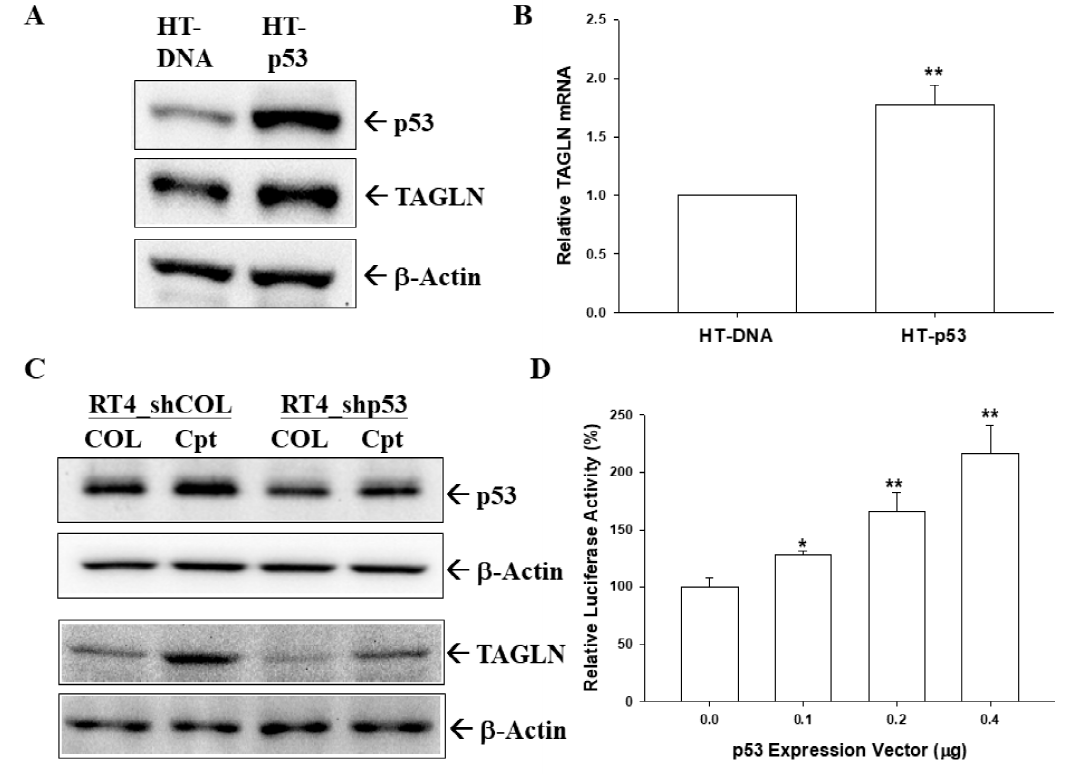
Figure 5. The ectopic overexpression of TAGLN attenuates tumorigenesis, in vivo, for bladder carcinoma HT1376 cells. Four-week-old male athymic nude (nu/nu) mice were randomized into two groups: HT-DNA ( n = 7; A ) and HT-TAGLN ( n = 7; B ). HT-DNA cells and HT-TAGLN cells (1 × 10 6 ) were injected subcutaneously in the dorsal area of the mice, respectively. The animal body weights ( C ) and tumor growth rates ( D ) were measured every 2 days, starting at the 3-weeks-of-growth point (day 26), at which the tumors became perceptible under the skin after inoculation. The tumor weights ( E ) and levels of TAGLN mRNA ( F ) were determined after the animals were sacrificed ( ± SE; n = 7). * represented the p < 0.05 and the ** represented the p < 0.01.